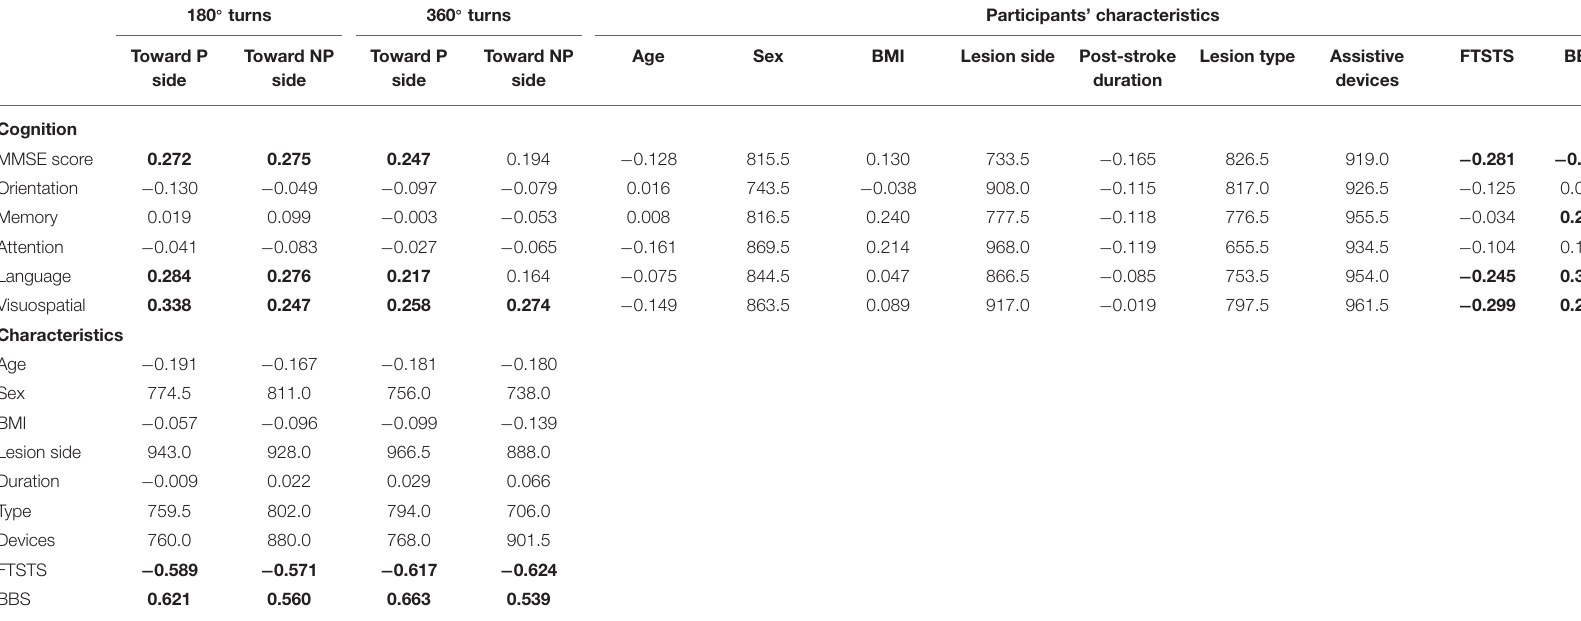
TABLE 2 | Correlation analysis between cognitive function, turning performance and participants’ characteristics in patients with